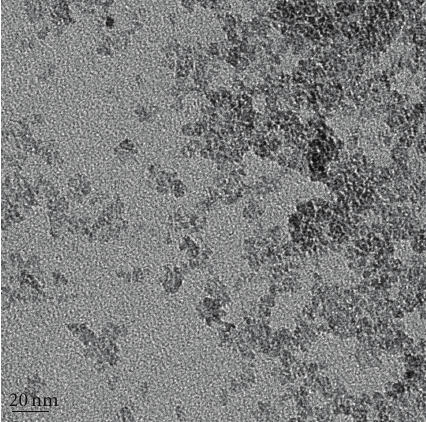
Figure 3: TEM image of the 102-3 TiO 2 sample. of TiO 2 are blue shifted compared with that of P25 TiO 2 . This can be explained by the sample composition, as anatase has a larger bandgap (3.2 eV) than rutile (3.0 eV). The 102 series of TiO 2 consists of pure anatase, while P25 TiO 2 is a mixture of anatase and rutile. For the 102 series of TiO 2 , due to the quantum size e ff ect, the order of the hypsochromic shifts of the absorption band edge is 102-3 > 102-1 ∼